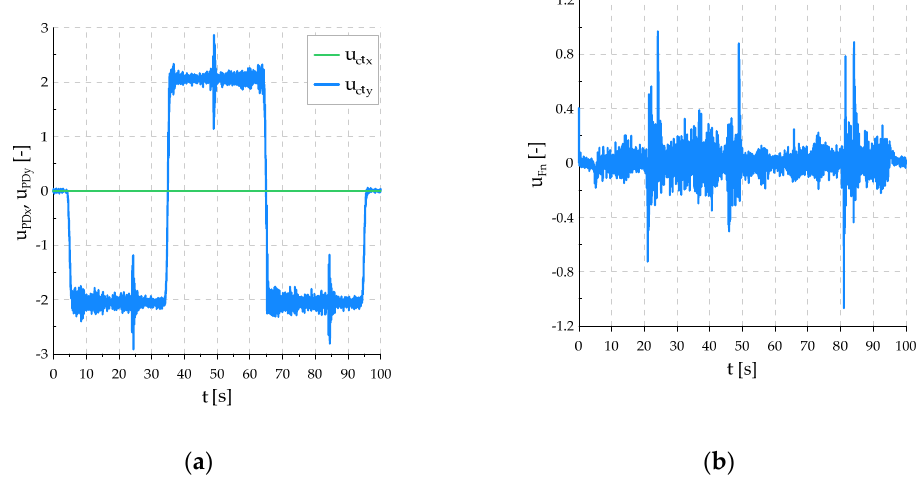
Figure 12. Control signals: ( a ) PD control signals in tangent directions; ( b ) PD control signal in normal direction.